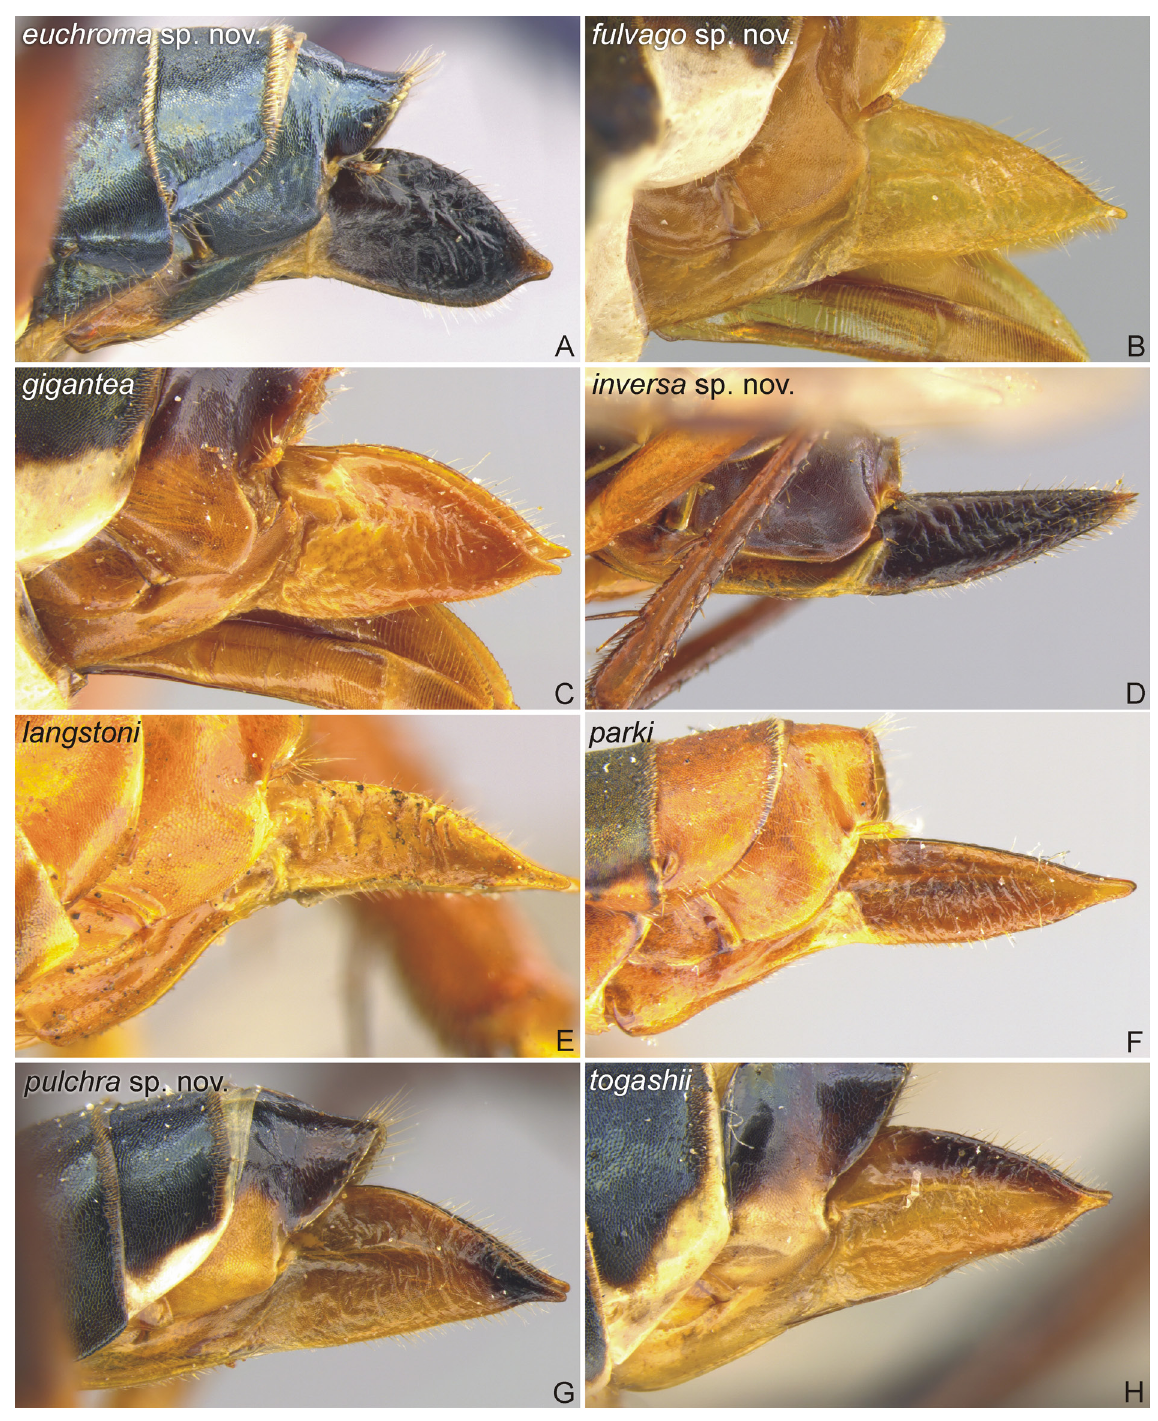
Fig. 11. Species of Megaxyela Ashmead, 1898, ovipositor sheaths. A . M. euchroma Blank, Shinohara & Wei sp. nov. (holotype, DEI-GISHym 22554, CSCS). B . M. fulvago Blank, Shinohara & Wei sp. nov. (5752, NSMT). C . M. gigantea Mocsáry, 1909, holotype of M. mikado Sato, 1930 (22350, NSMT). D . M. inversa Blank & D.R. Smith sp. nov., paratype (22356, USNM). E . M. langstoni Ross, 1936, holotype (30821, INHS). F . M. parki Shinohara, 1992 (18510, NSMT). G . M. pulchra Blank, Shinohara & Sundukov sp. nov., holotype (18501, NSMT). H . M. togashii Shinohara, 1992, holotype (22352, NSMT). Images not to the